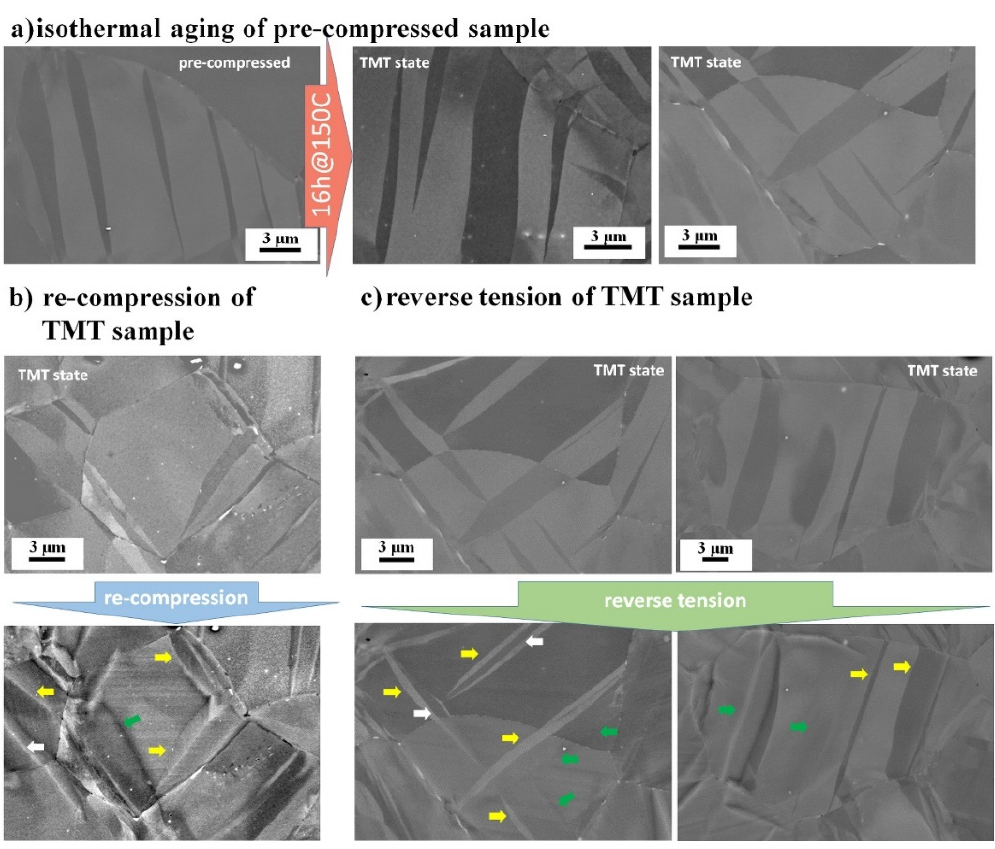
Figure 3. Backscattered electron (BSE) images of the ZX10 alloy: ( a ) with respect to the isothermal aging to achieve TMT state (pre-compression up to 140 MPa and subsequent isothermal aging at 150 °C for 16 h); followed by ( b ) re-compression up to 3% of strain or ( c ) reverse tension up to 2% of strain. ED is horizontal. Colored arrows highlight: yellow-immobile twin boundaries (TB); green–mobile TB; white–newly nucleated twins, accordingly.